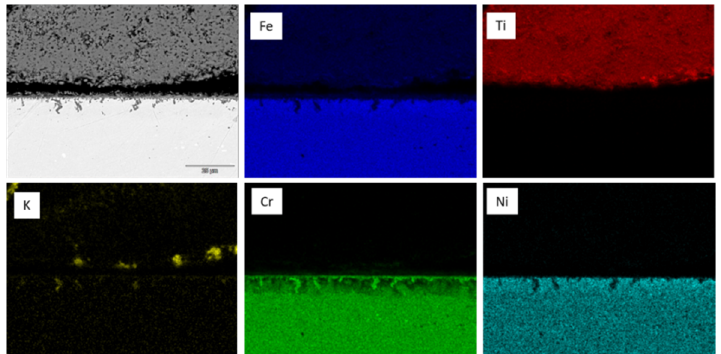
Figure 11. Back-scattered SEM image and elemental maps of TP347 covered with oxidized K-Ilmenite after exposure at 700 °C, in air during 168 h showing K (yellow), Fe (blue), Ti (red), Cr (green), and Mo (cyan).